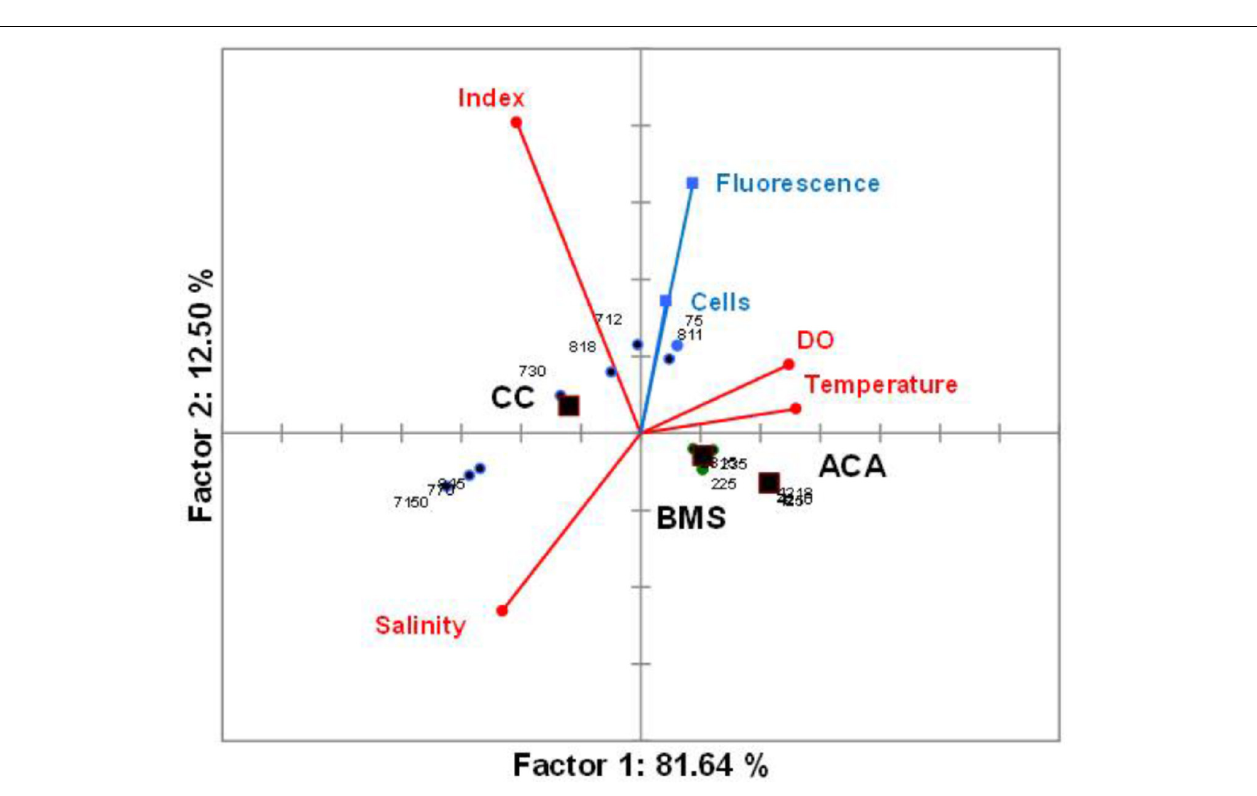
FIGURE 8 | Principal component analysis (PCA) biplot (variables and samples) of the two first components from data of environmental and biotic variables of the central Mexican Pacific. Circles represent the samples and squares are the centroids for qualitative variables. CC, Cabo Corrientes; BMS, Manzanillo; and ACA, Acapulco